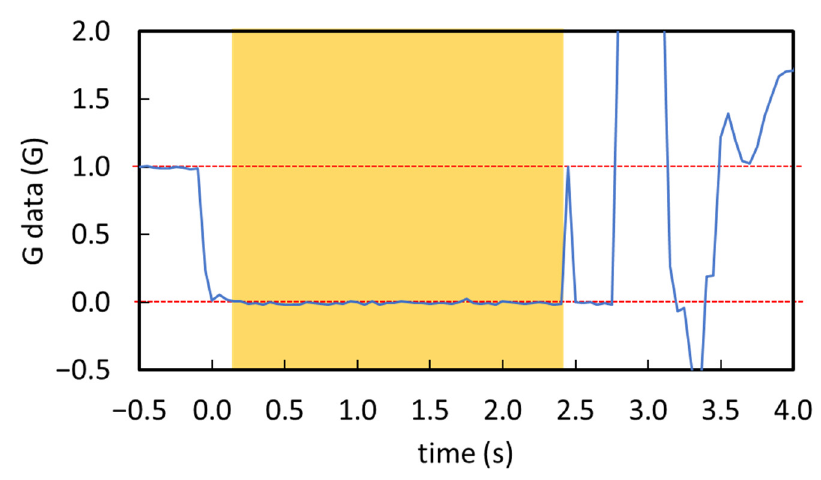
Figure 3. Typical gravity observed from the free fall from the drop tower. The shaded area represents the analyzed period in which the solenoid valve was opened to let water infiltrate into the glass beads.